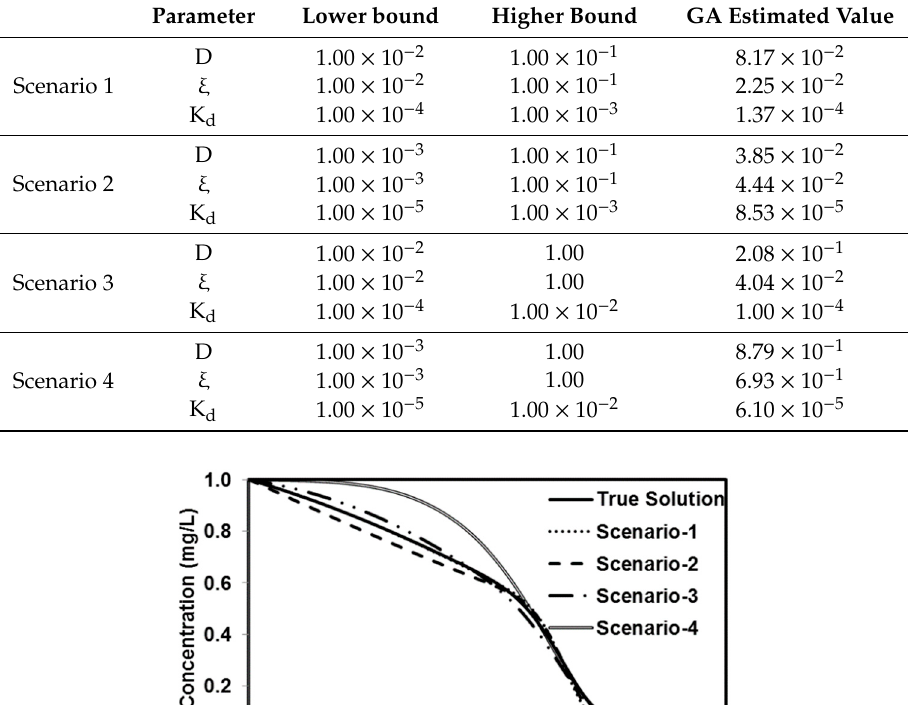
Table 8. High and low bounds for the four di ff erent scenarios along with the PGA-estimated value.